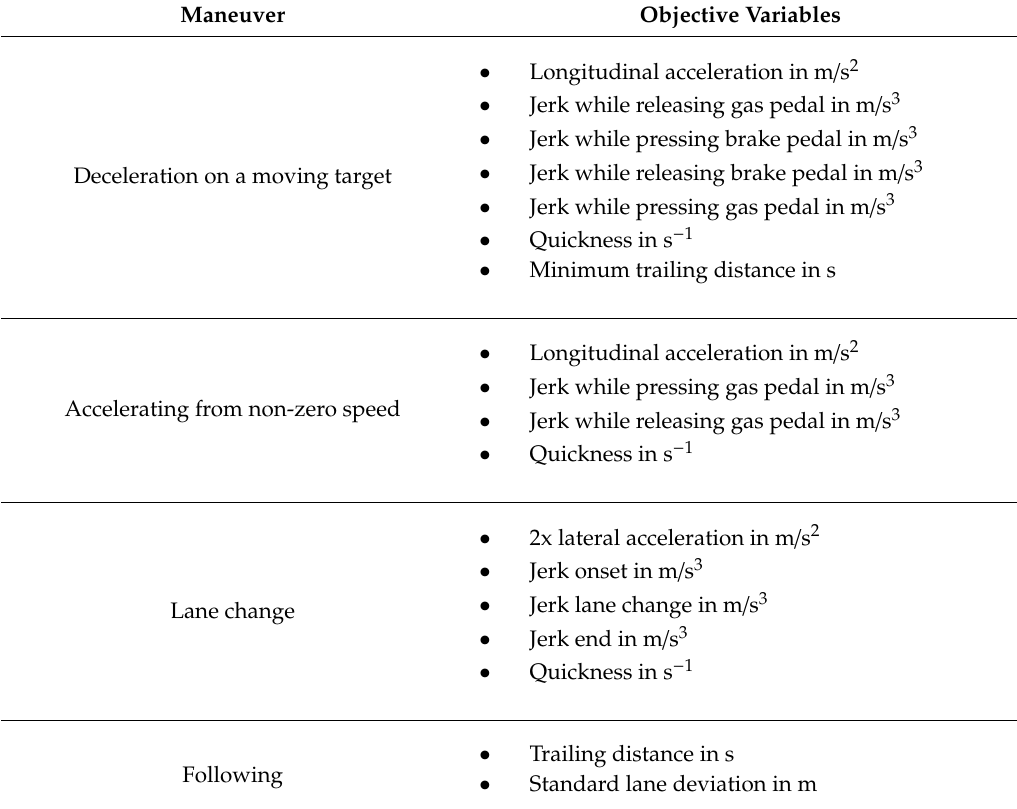
Table 1. Objective variables for the objectification of driving comfort, adapted from